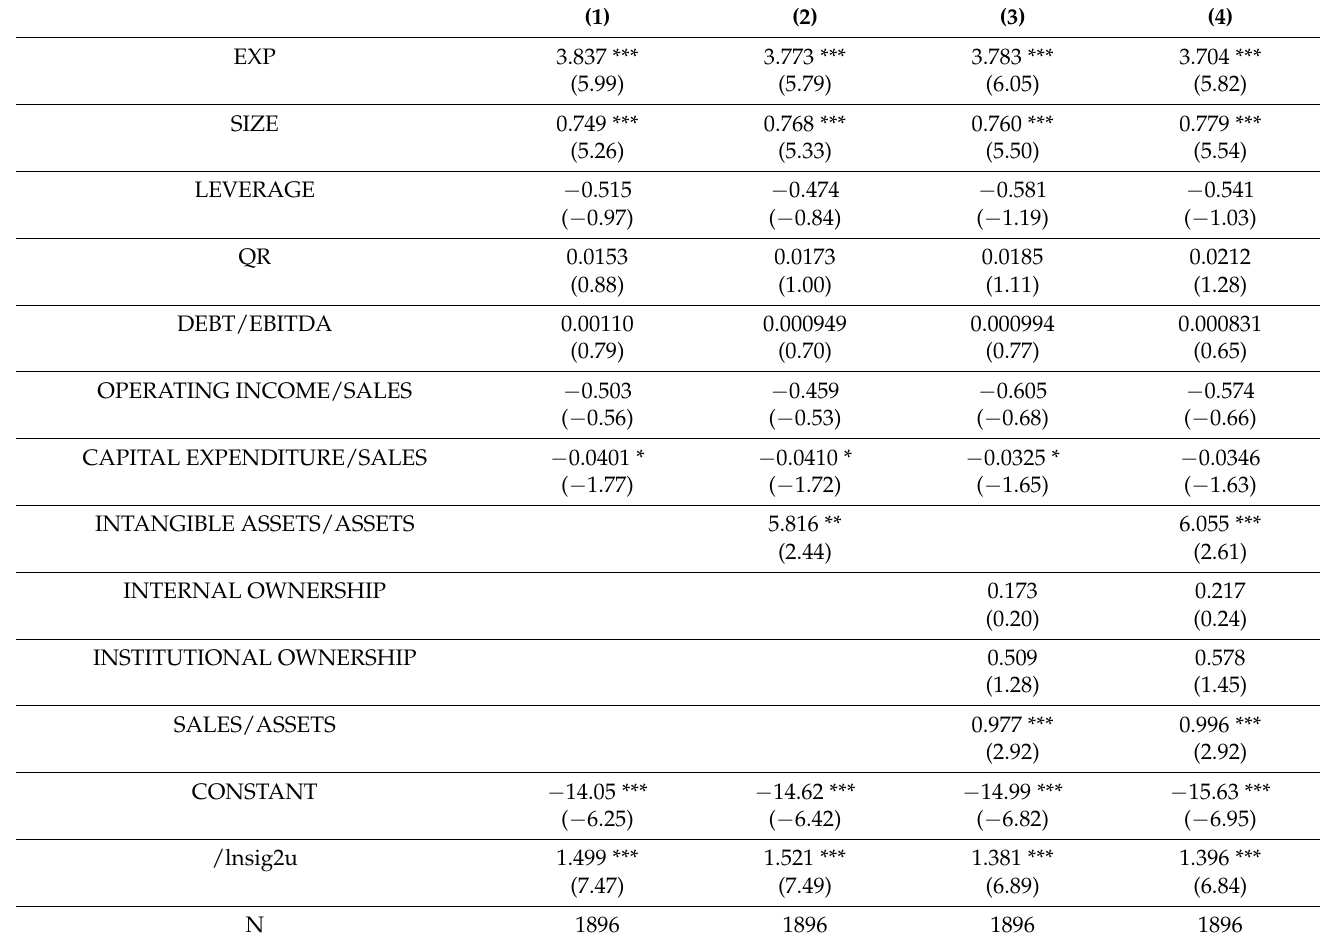
Table 3. Determinants of foreign currency derivatives: Static